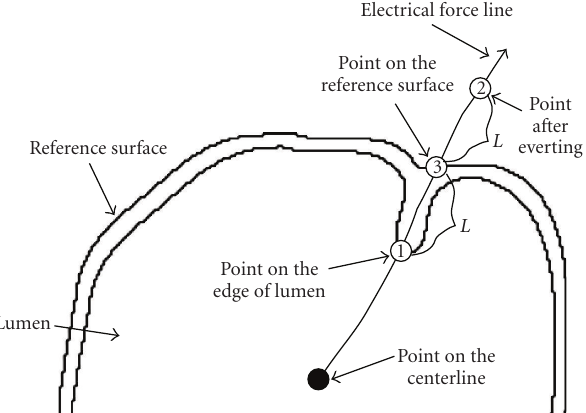
Figure 3: Everting process with respect to an electrical force line, which is from a centerline point in a curved cross-section. Along the force line, the length of a curved segment from point (1) to point (3) equals the length of a curved segment from point (3) to point (2).